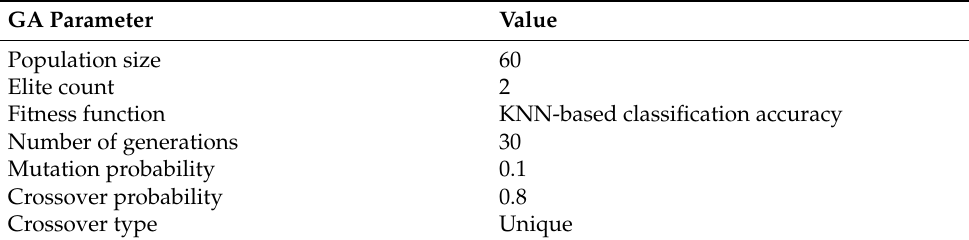
Table A8. Parameters used in GA for selecting optimum features.